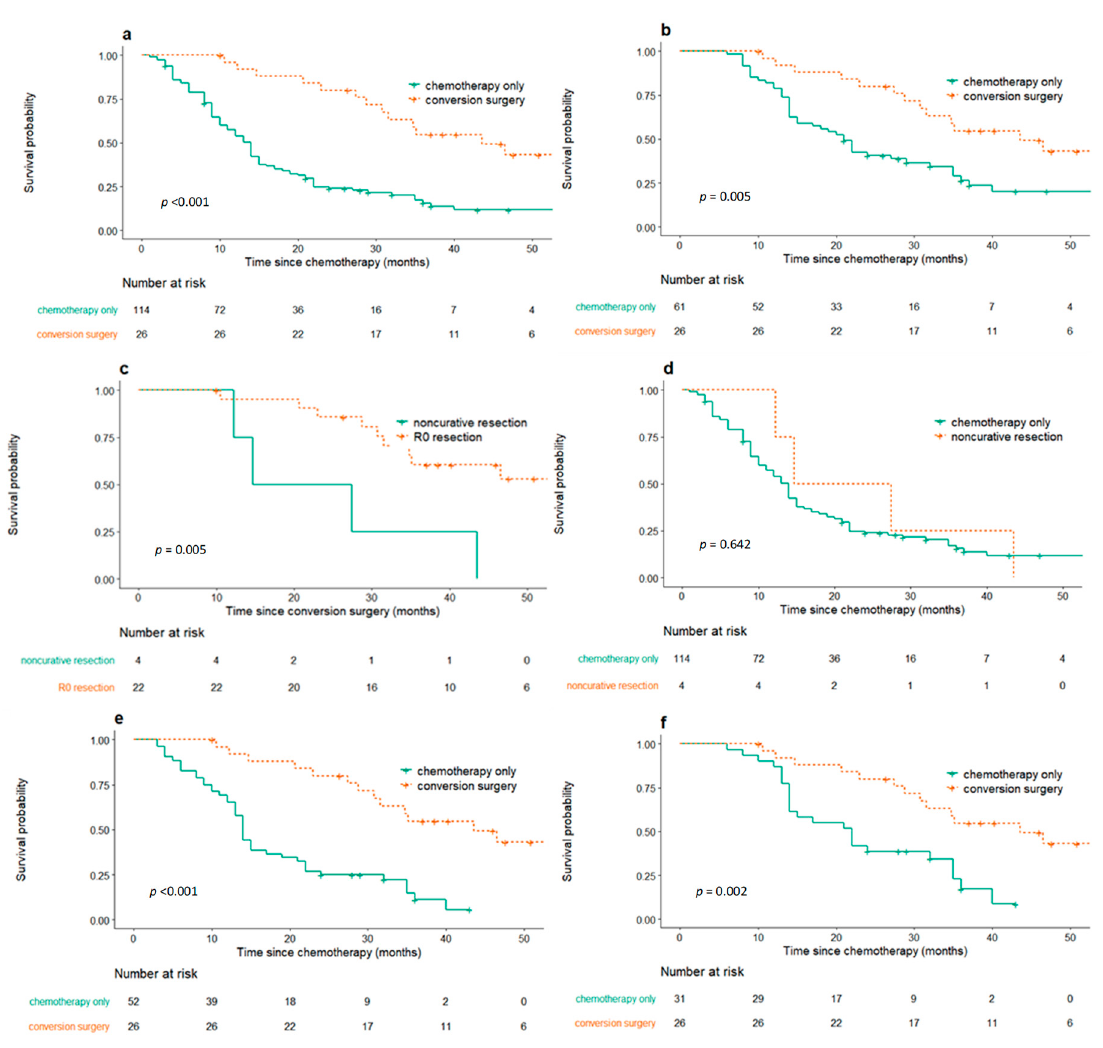
Figure 1. Kaplan–Meier curve for overall survival (OS) in patients who received conversion surgery and only chemotherapy. ( a ) Comparison of OS after chemotherapy in patients who received conversion surgery ( n = 26) and those that only received chemotherapy ( n = 114) ( p < 0.001). ( b ) Comparison of OS after chemotherapy in patients who received conversion surgery ( n = 26) vs. subgroup of patients in the chemotherapy only group whose tumor responded to or were stabilized with chemotherapy for 5.1 or more months ( n = 61) ( p = 0.005). ( c ) Comparison of OS in patients who received R0 resection ( n = 22) vs. noncurative resection in conversion surgery ( n = 4) ( p = 0.005). ( d ) Comparison of OS after chemotherapy in patients who received noncurative resection in conversion surgery ( n = 4) vs. only chemotherapy ( n = 114) ( p = 0.642). ( e ) After propensity score matching, comparison of OS after chemotherapy in patients who received conversion surgery ( n = 26) vs. only chemotherapy ( n = 52) after propensity score matching ( p < 0.001). ( f ) After propensity score matching, comparison of OS after chemotherapy in patients who received conversion surgery ( n = 26) vs. subgroup of patients with tumor response of 5.1 or more months after propensity score matching ( n = 31) ( p = 0.002).